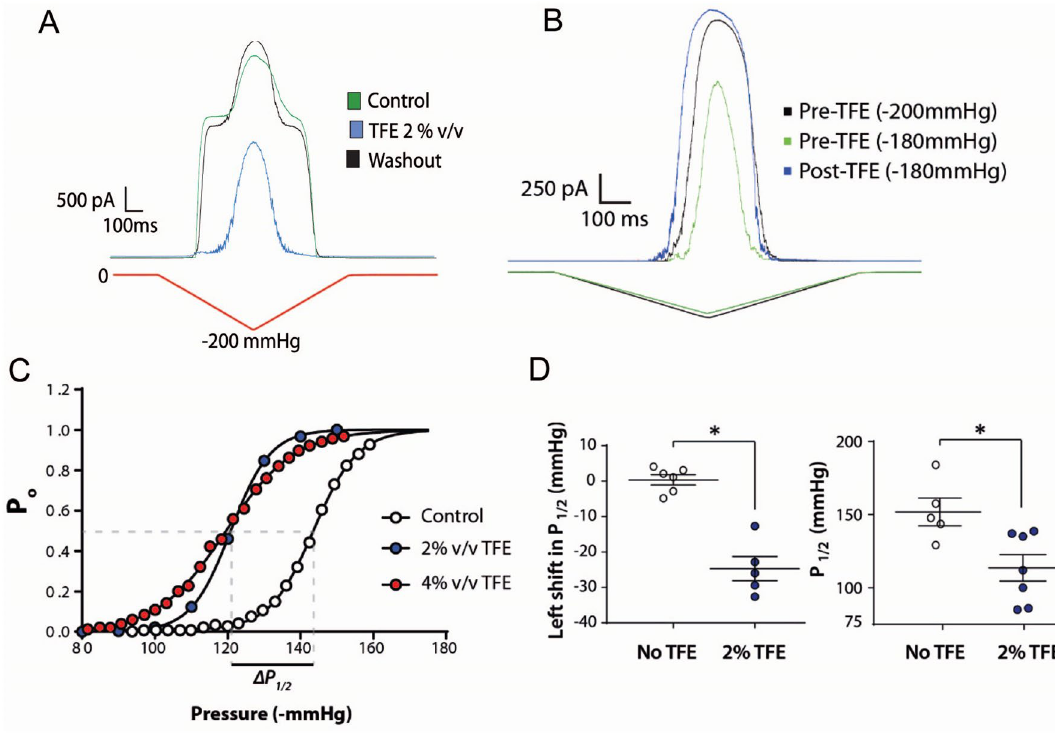
Figure 6. Differential effect of TFE on MscL and MscS expressed in MJF612 E. coli spheroplasts. ( A ) MscL and MscS are activated by application of a pressure ramp to an excised spheroplast patch (green and